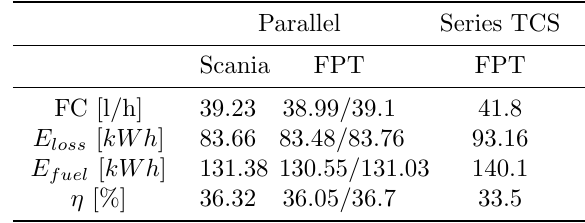
Table 3: The component dimensions of the excavator